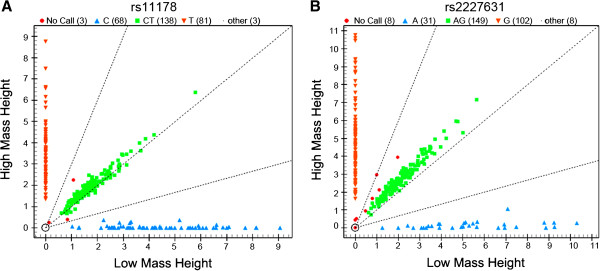
Clustering graphs of genotypes for rs11178 (+10700 C/T in the 3′UTR, A) and rs2227631 (-844 G/A in the promoter, B). The genotyping success rate was over 95%.